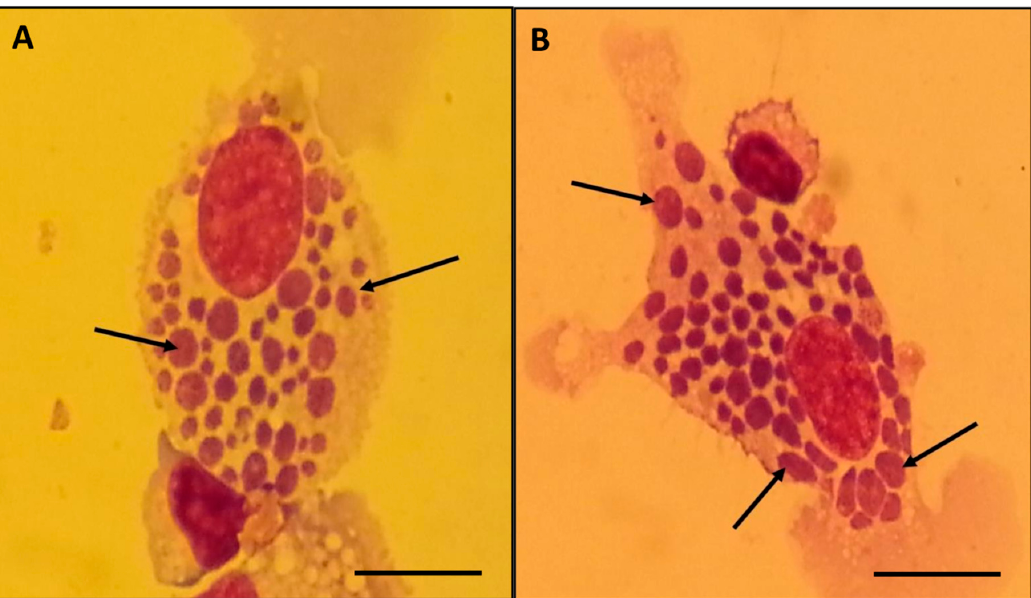
Figure 1. Romanowsky-stained smears showing large morulae of E. minasensis (arrows) in the cytoplasm of calf monocytes. Images ( A ) and ( B ) each show a different monocyte heavily infected with multiple morulae of E. minasensis . Magnification, 1000×. Bar = 10 µm. One day after the ehrlichial morulae were observed in the primary culture, DH82 cells were added in the primary culture. Seven days later, ehrlichial morulae were observed within the cytoplasm of 10% of the DH82 cells (Figure 2).